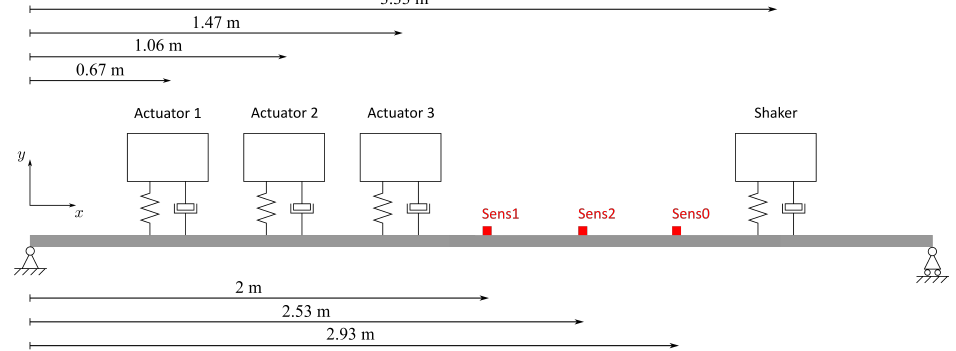
Figure 3. Experimental test rig ( a ) and the stand-alone device ( b ).